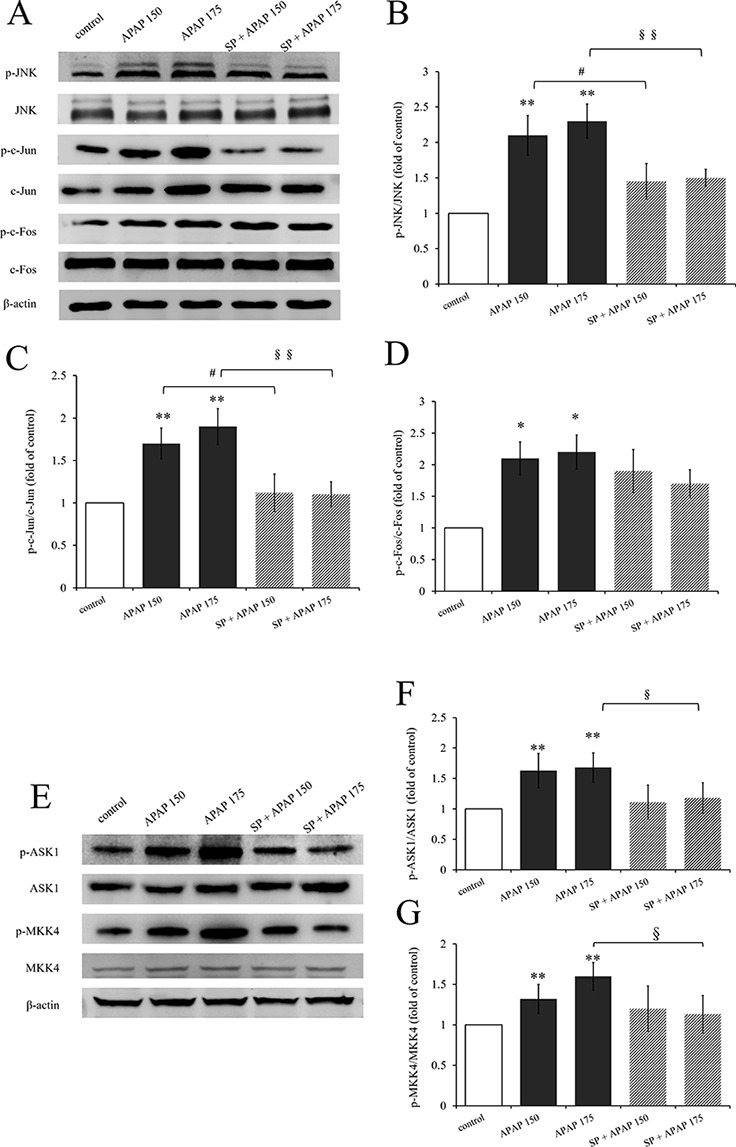
Activation of JNK signaling pathway under different dosages of APAP. (A) Western blot analyses of total tissue lysate for p-JNK, JNK, p-c-Jun, c-Jun, p-c-Fos, c-Fos, and β-actin (loading control). (B–D, F, G) Change of JNK activation (fold of p-JNK/JNK), c-Jun activation (fold of p-c-Jun/c-Jun), c-Fos activation (fold of p-c-Fos/c-Fos), ASK1 activation (fold of p-ASK1/ASK1), and MKK4 activation (fold of p-MKK4/MKK4) under different dosages of APAP in liver of mice with or without SP600125. (E) Western blot analyses of total tissue lysate for p-ASK1, ASK1, p-MKK4, MKK4, and β-actin (loading control). Values represented as means ± SD, n = 3. *Represents statistical differences caused by APAP. #Represents statistical differences caused by SP600125 under 150 mg·kg−1 APAP; §Represents statistical differences caused by SP600125 under 175 mg·kg−1 APAP. 0.05 > P > 0.01 (*, #, §). P < 0.01 (**, §§).